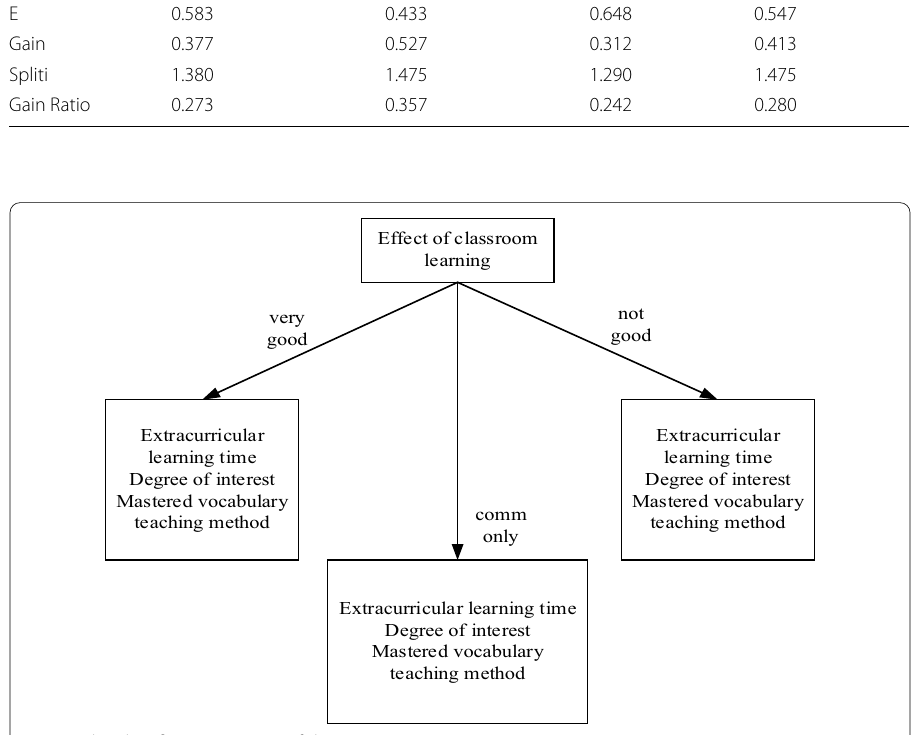
Fig. 3 The classification process of decision